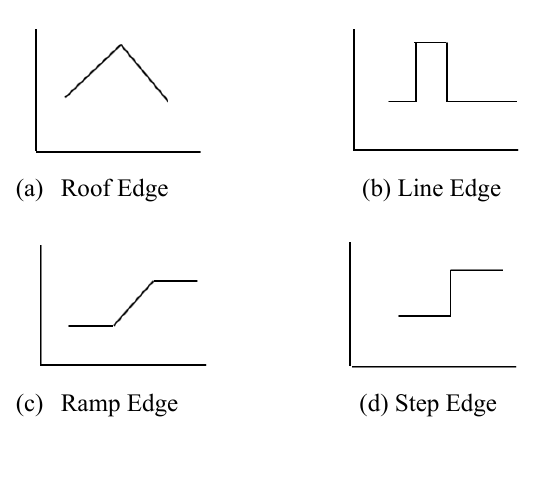
Figure 1. Categories of Edge